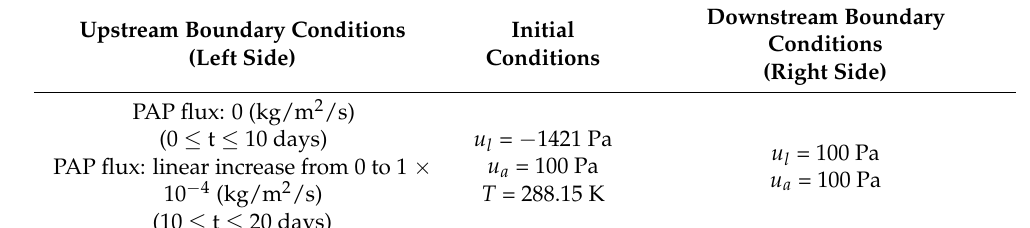
Table 10. Initial and boundary conditions for verification test.